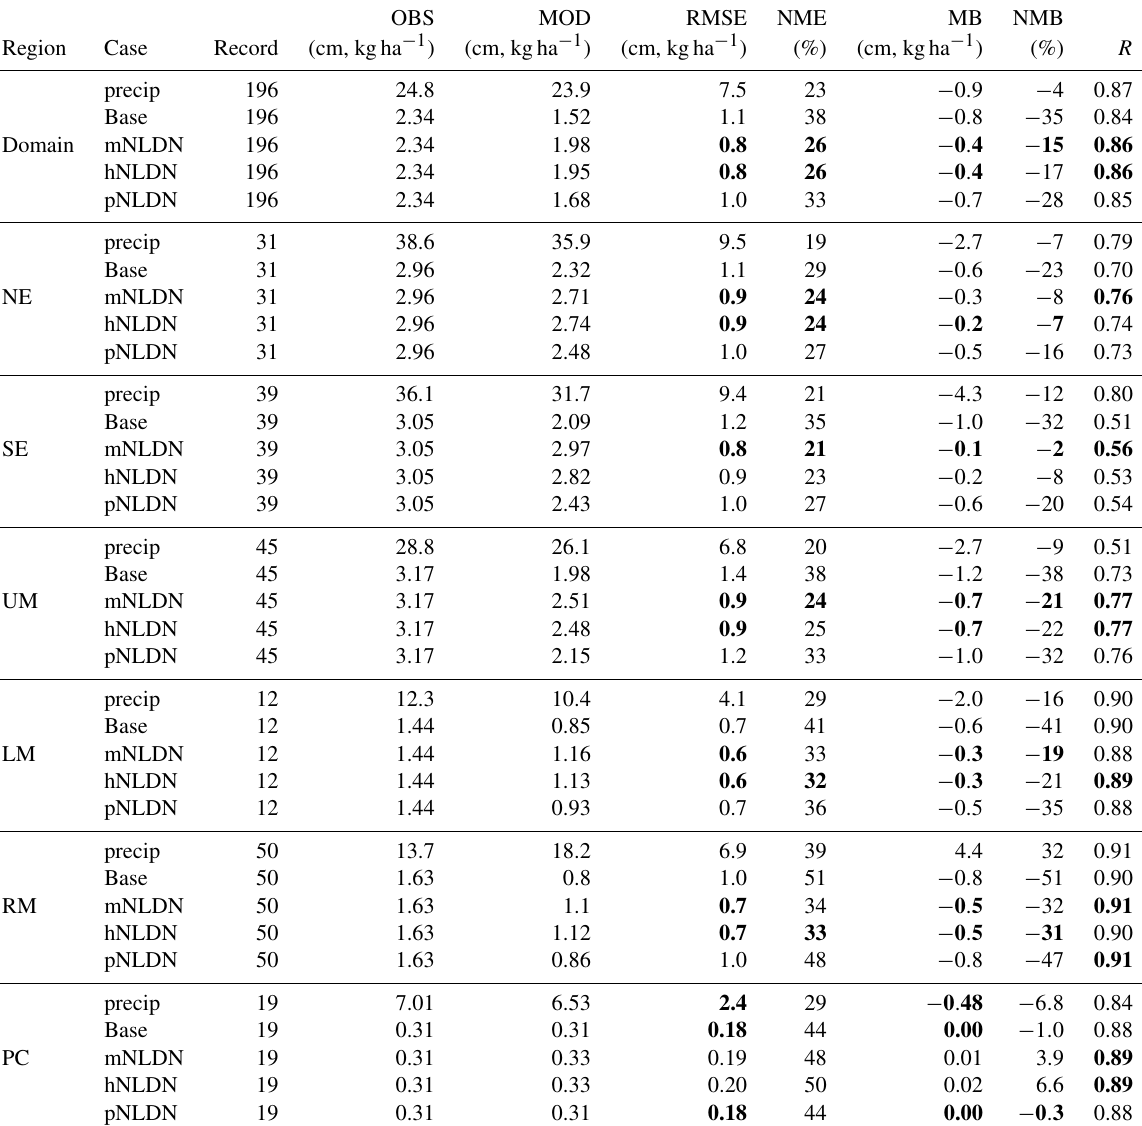
Table 3. Statistics of June–August 2011 accumulated precipitation (cm) and wet deposition of nitrate (NO − domain. The best performance metrics among the model cases are highlighted in